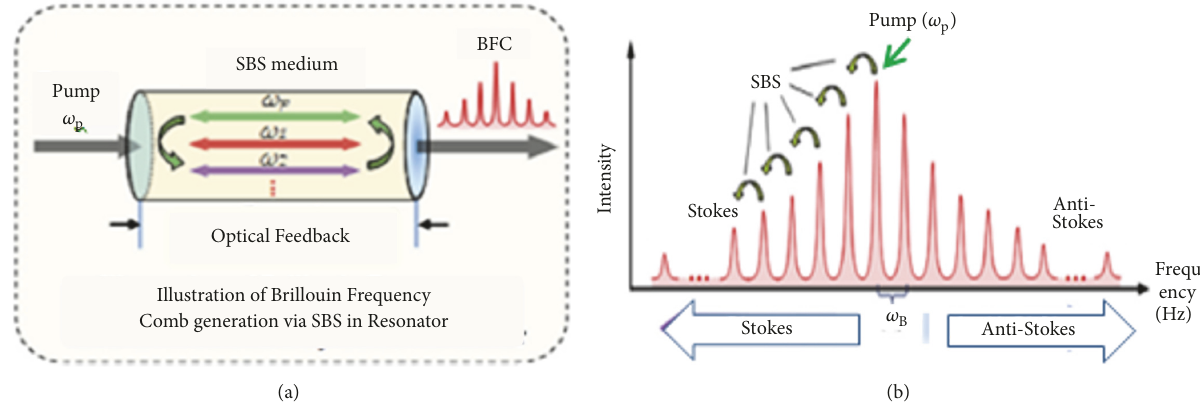
Figure 11: Principle of Brillouin frequency comb (BFC) generation [adapted from